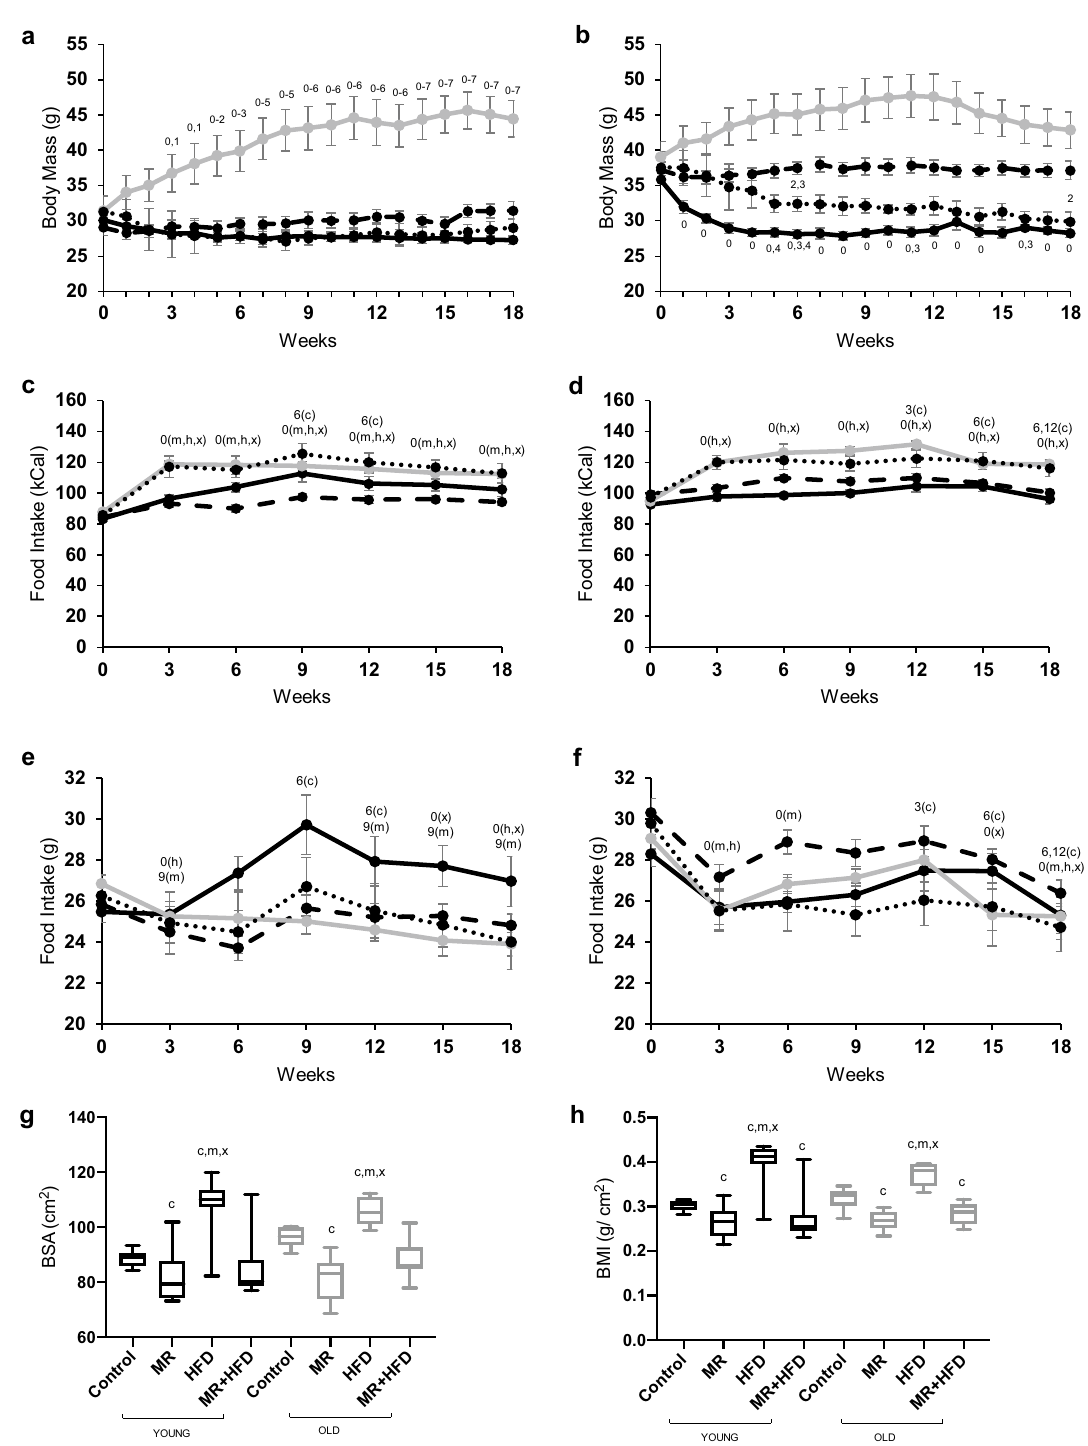
Figure 1. Body mass (g) ( a , b ), food intake in kCal ( c , d ) and grams ( e , f ), body surface area ( g ), body mass index (BMI) ( h ) in young ( a , c , e ) and old ( b , d , f ) mice for 18 weeks on a control (dash line), methionine restricted (MR) (solid black line), high fat diet (HFD) (grey line) or MR + HFD (dotted line) diet. 0, 1, 2, 3, 4, 5, 6, 7, 9: significantly different from weeks 0, 1, 2, 3, 4, 5, 6, 7, 9 respectively; c, m, x: significantly different from control, MR, MR + HFD group, respectively; for food intake ( c – f ) c, m, h, x: control, MR, HFD, MR + HFD, respectively, represent the diet groups in which these differences are observed all at p < 0.05. Data is presented as mean ± SEM ( a – f ) and mean, min, max ( g , h